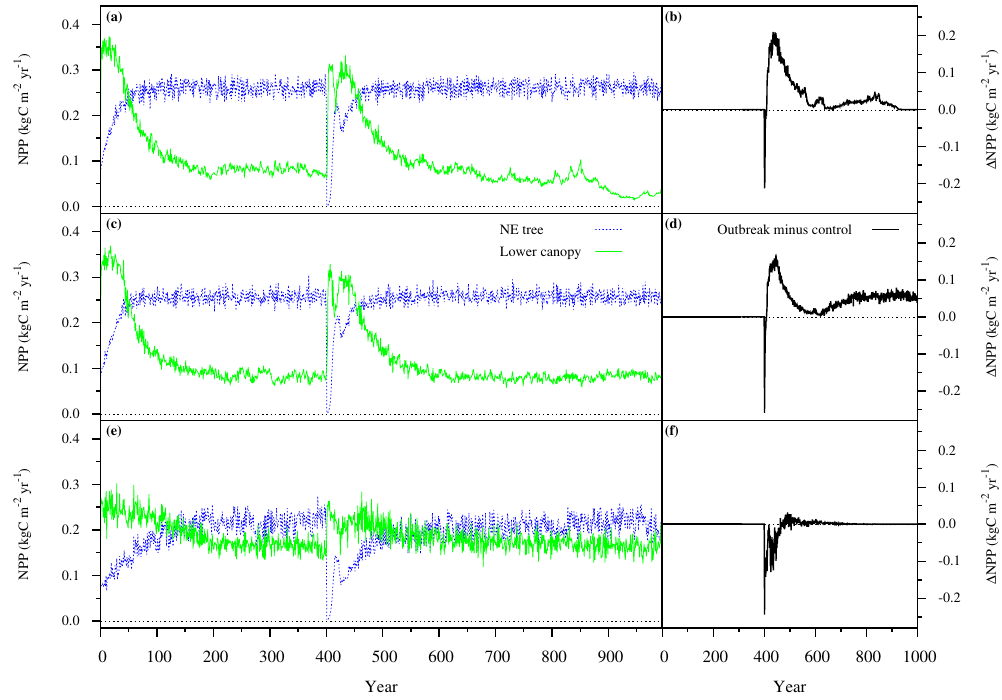
Figure 2. NPP results for an MPB outbreak (100% mortality on year 401) simulated in IBIS–MIM: NPP of different PFTs ( a , c , and e ) and difference in total NPP with the control simulation ( b , d , and f ). NE is needleleaf evergreen; lower canopy is sum of evergreen shrubs, cold-deciduous shrubs, and C 3 grasses. (a, b) Northern grid cell. (c, d) Central grid cell. (e, f) Southern grid